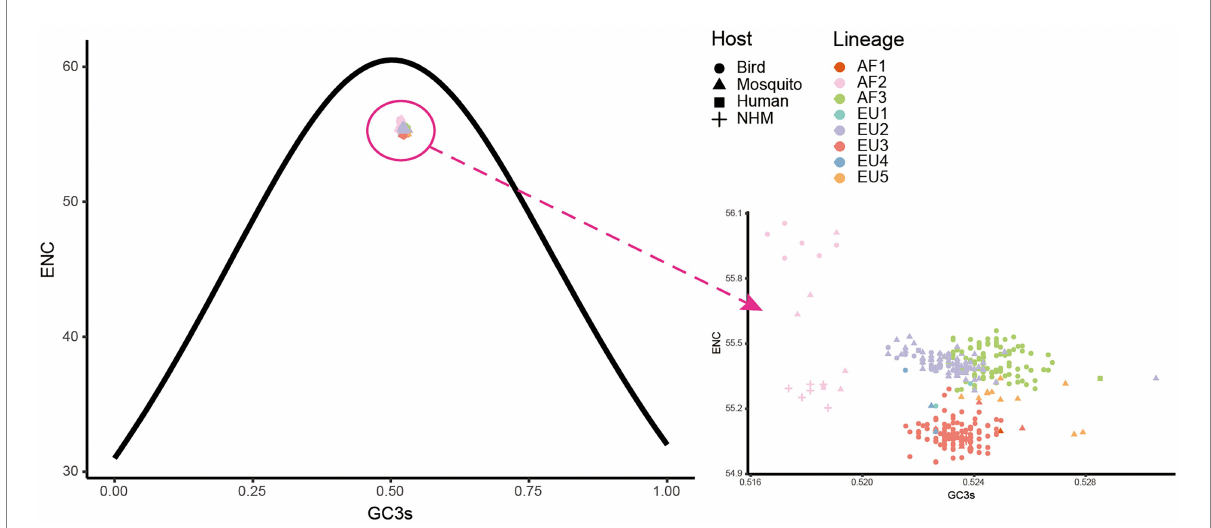
FIGURE 6 The effective number of codons (ENC) plot of whole coding sequences of USUVs. The solid curve represents the expected ENC values when the codon usage was only influenced by the GC3s composition. The point shape and color are depicted according to isolation host and lineage classification.